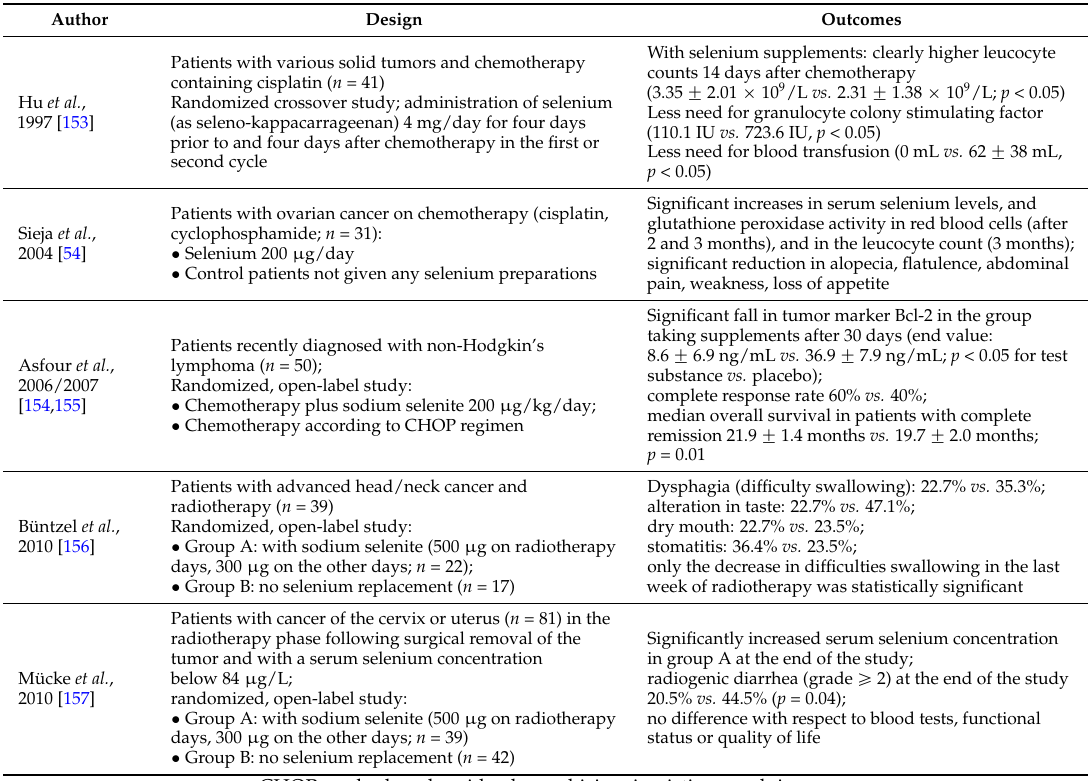
Table 3. Studies on the use of high-dose selenium during chemo- or